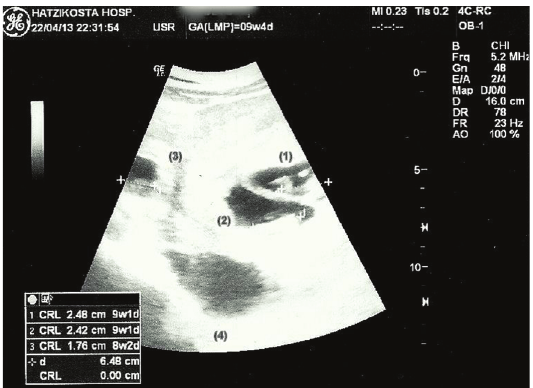
Figure 1: Ultrasound examination shows an intrauterine twin pregnancy (1, 2) with crown-rump length measurements of 24,8 (1) and24,2(2)mmaccordingto 9 +1 weeks,athirdgestationalsacinthe right uterine adnexa (3) with an embryo measuring 17,6 mm length and free fluid in the pouch of Douglas